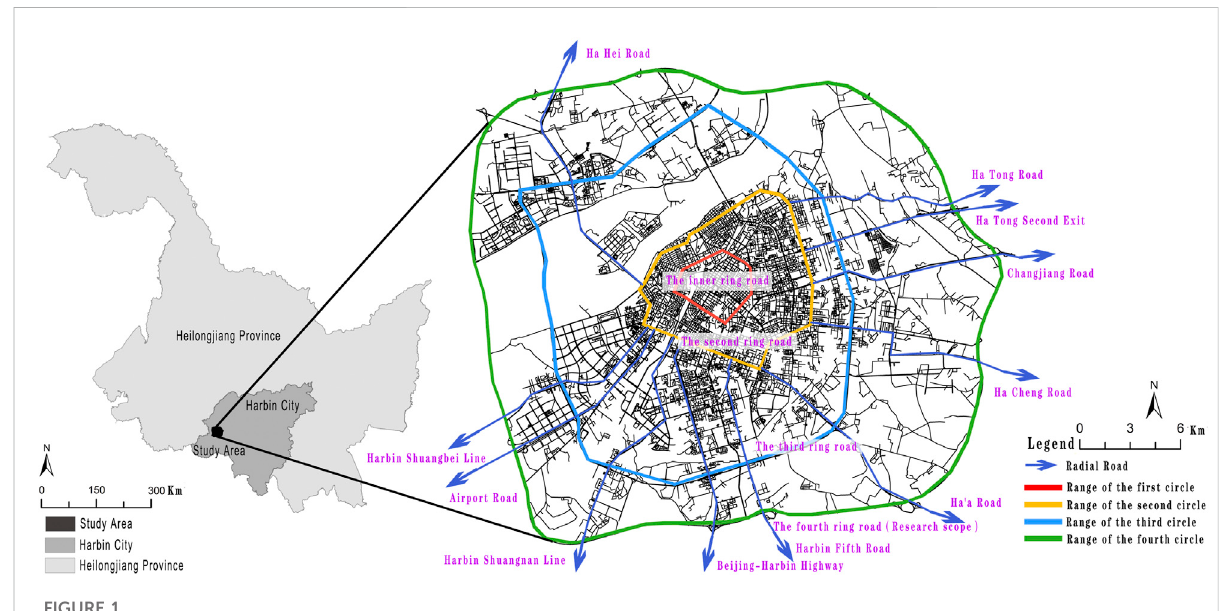
FIGURE 1 The location and study area (the 4th ring road, Harbin,